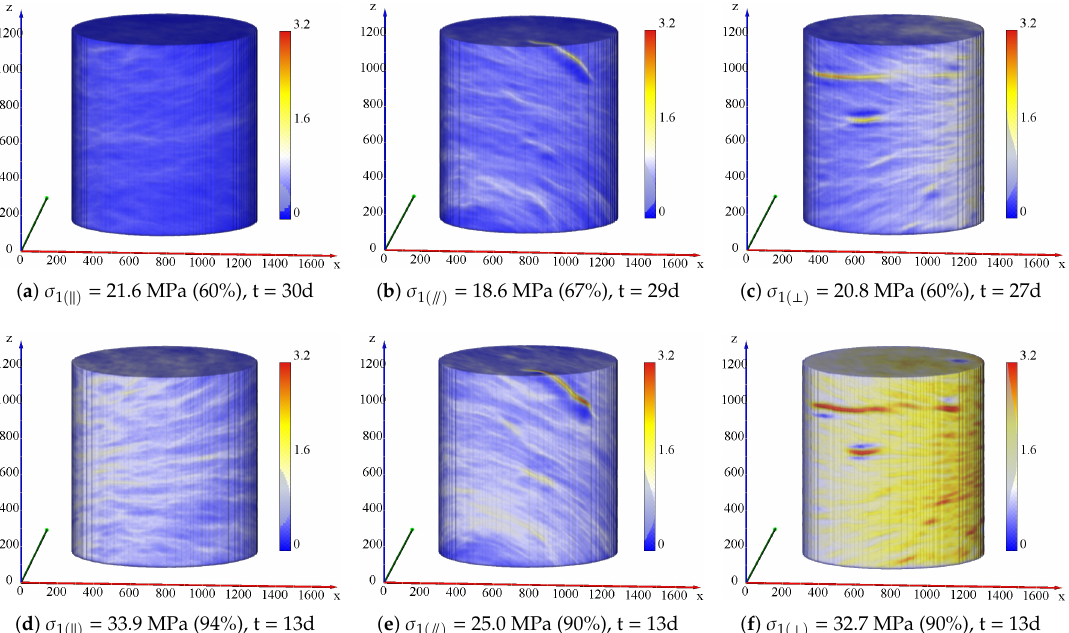
Figure 7. Distributions of accumulated axial strain under di ff erent stress levels and at di ff erent instances: ( a , d ): parallel sample ( (cid:107) ) with q c / q peak = 60% and q c / q peak = 94%; ( b , e ): inclined sample ( ∥ ) with q c / q peak = 67% and q = 90%; ( c , f ): perpendicular sample ( ⊥ ) with q c / q peak